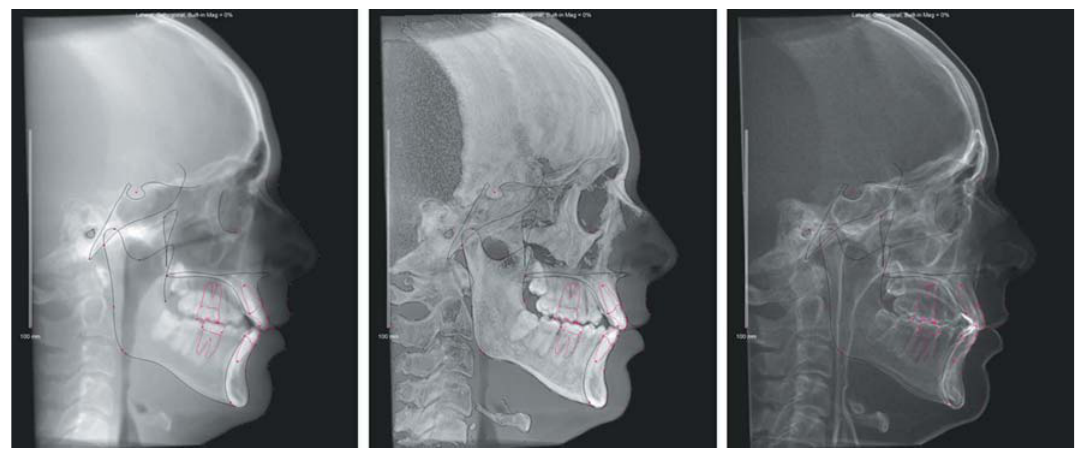
Figure 4- Filters of the software Dolphin